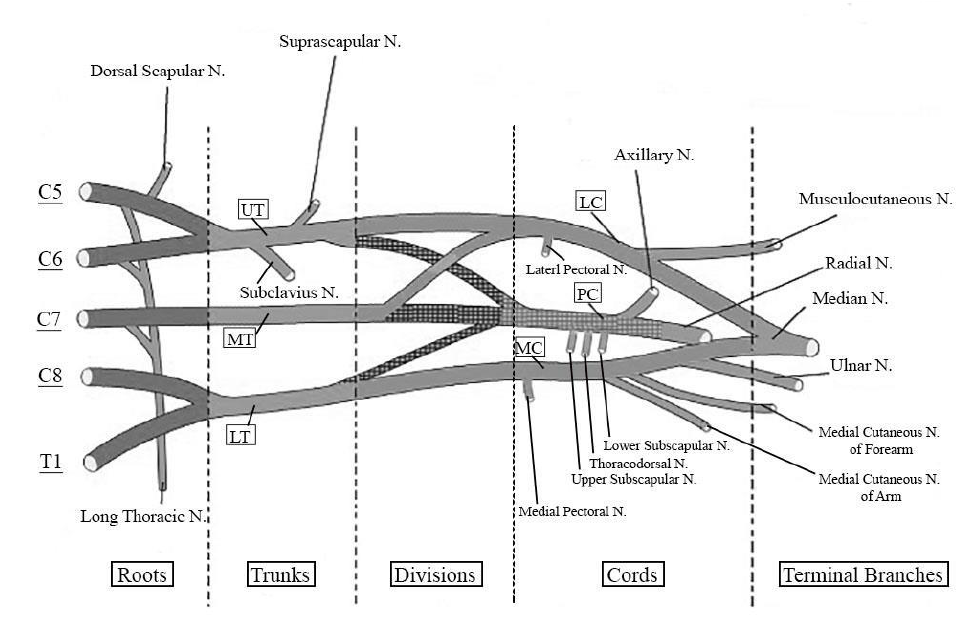
Figure 2. Schematic representation of brachial plexus. UT: Upper Trunk. MT: Middle Trunk. LT: Lower Trunk. LC: Lateral Cord. PC: Posterior Cord. MC: Medial Cord. N: Nerve.